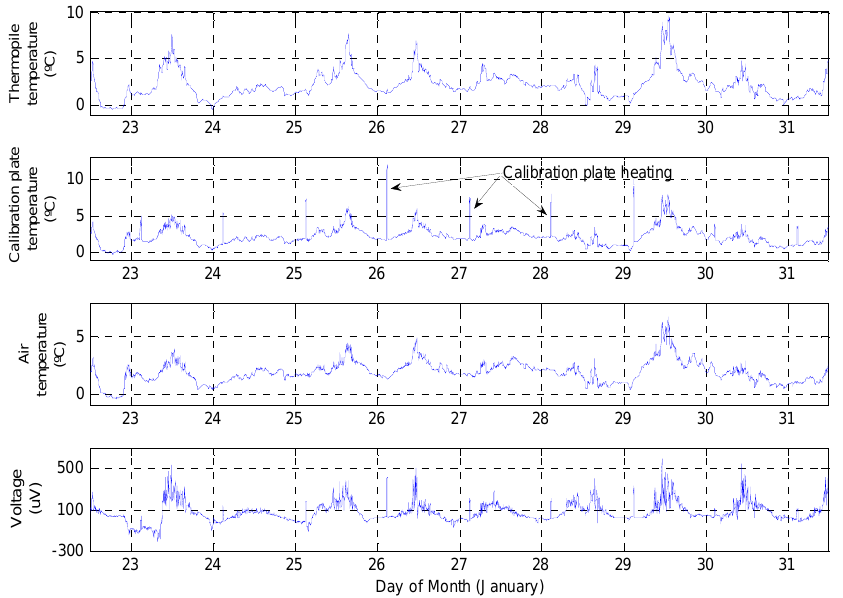
Figure 9. Output signals of the GTS engineering model during the measuring period.